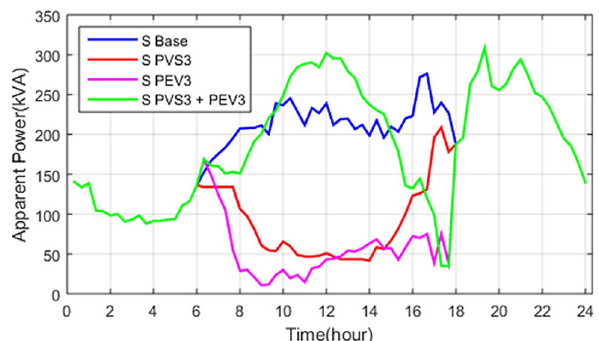
Figure 6. Analysis of day-to-day outlines of the feeder 1 to 2 loads (any type) thru summertime.